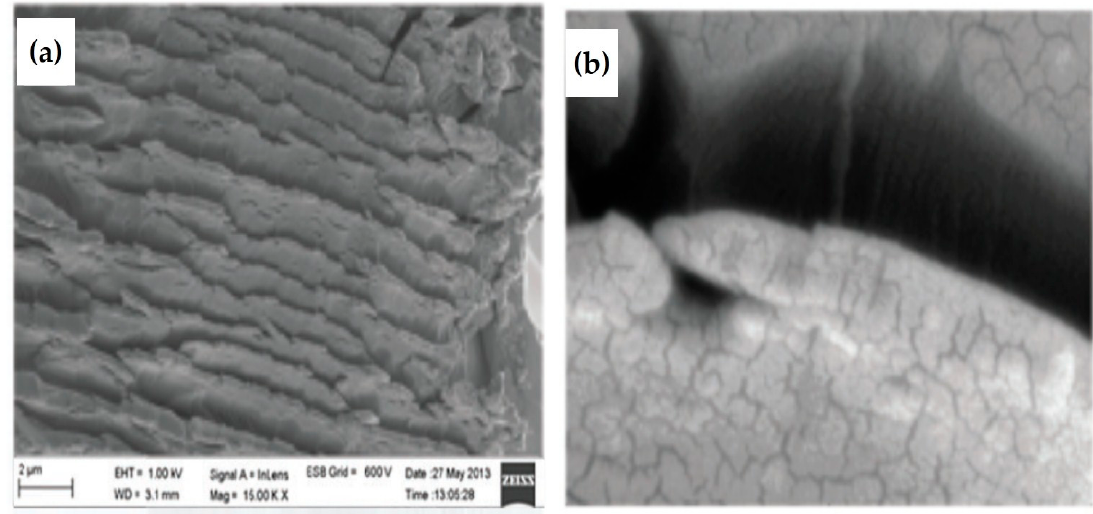
Figure 7. Cryo-SEM image of ( a ) octadecylamine functionalized graphene DLC composites showing a layered structure and ( b ) enlarged portion of ( a ) showing graphene layers inserted with discotics. Reproduced with permission [57].